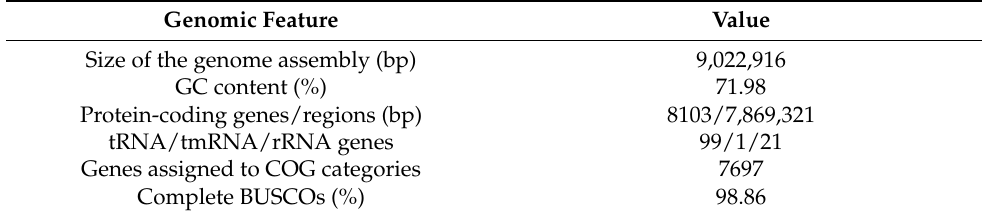
Table 1. Genomic features of S. nojiriensis JCM 3382.